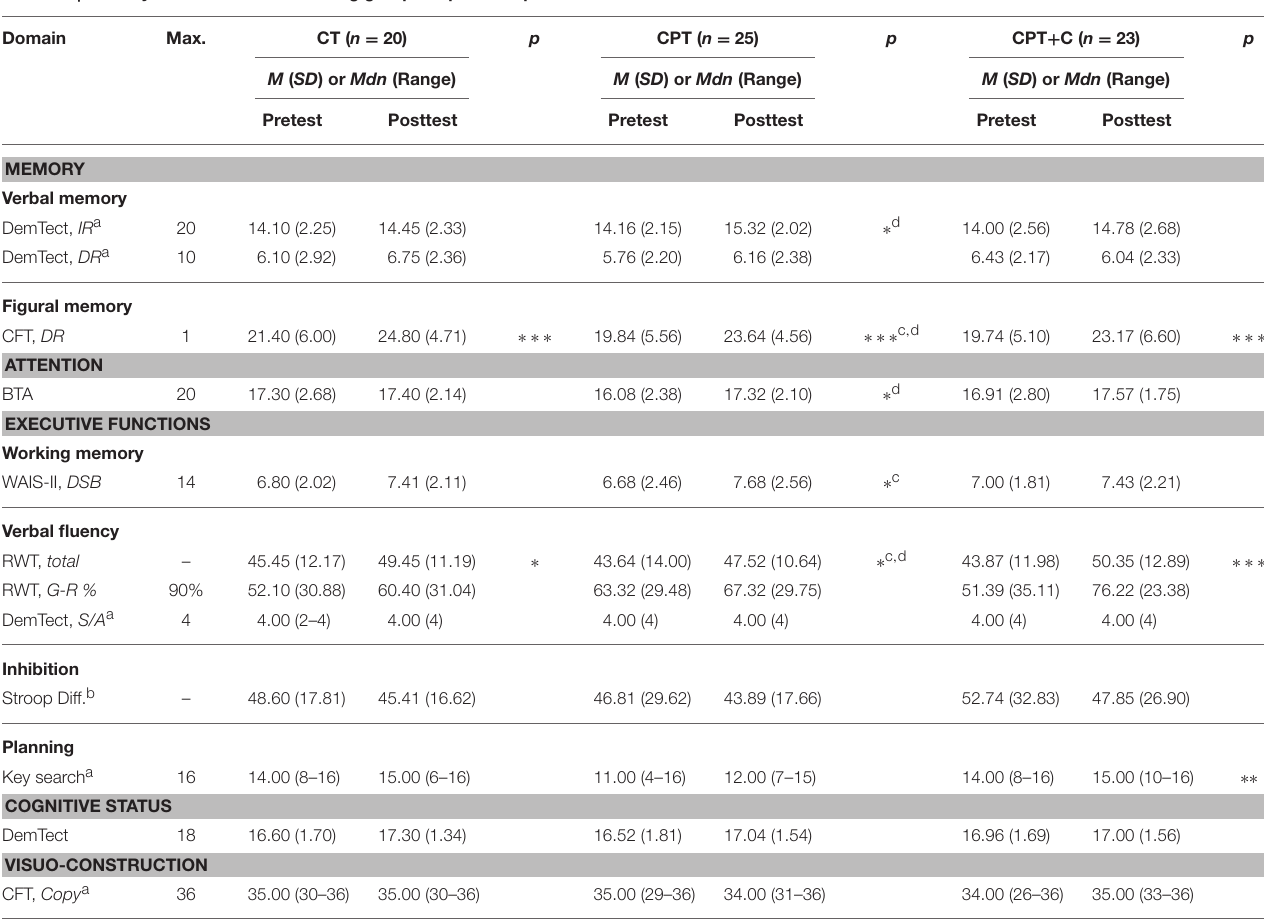
TABLE 2 | Primary outcomes of the training groups at pre- and post-test. Domain